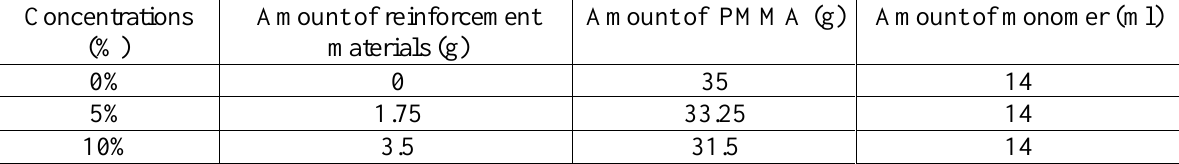
Table 1. Concentration and amounts of Polymer, Monomer and Sisal fibers used in this study.